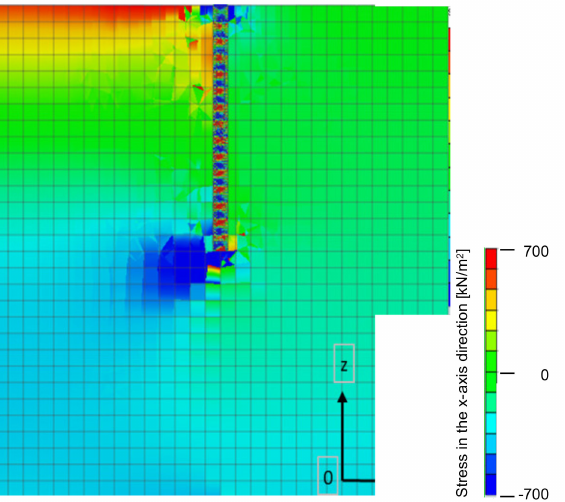
Figure 9. Top view of stress distribution in x -axis direction inside ground for Case-3.